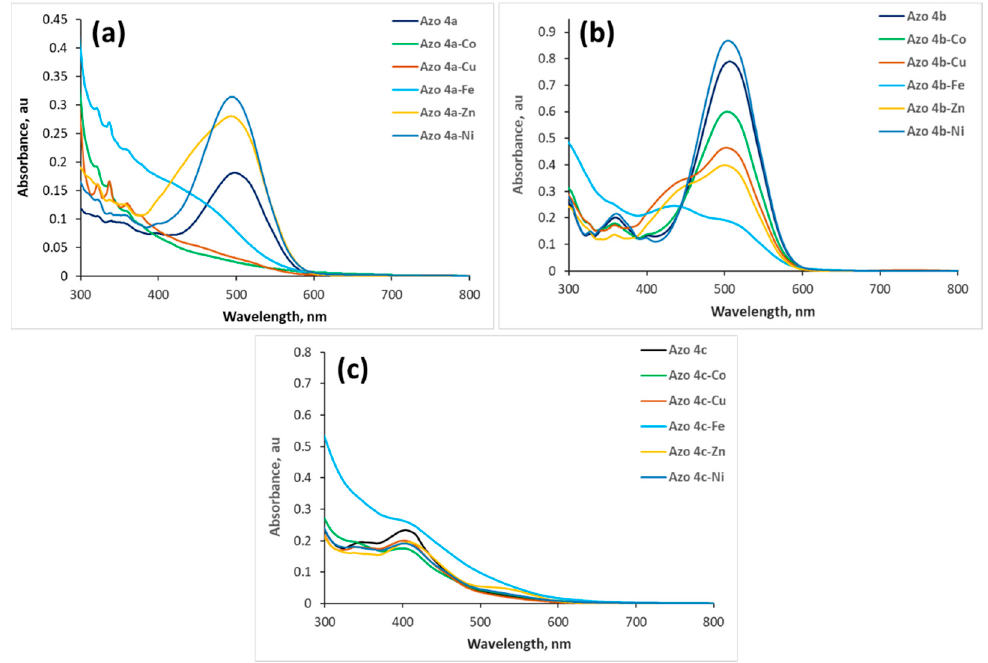
Figure 3. UV–vis spectra of azos 4a ( a ), 4b ( b ), and 4c ( c ) (2.5 × 10 − 5 M) upon addition of four equivalents of different metal ions.